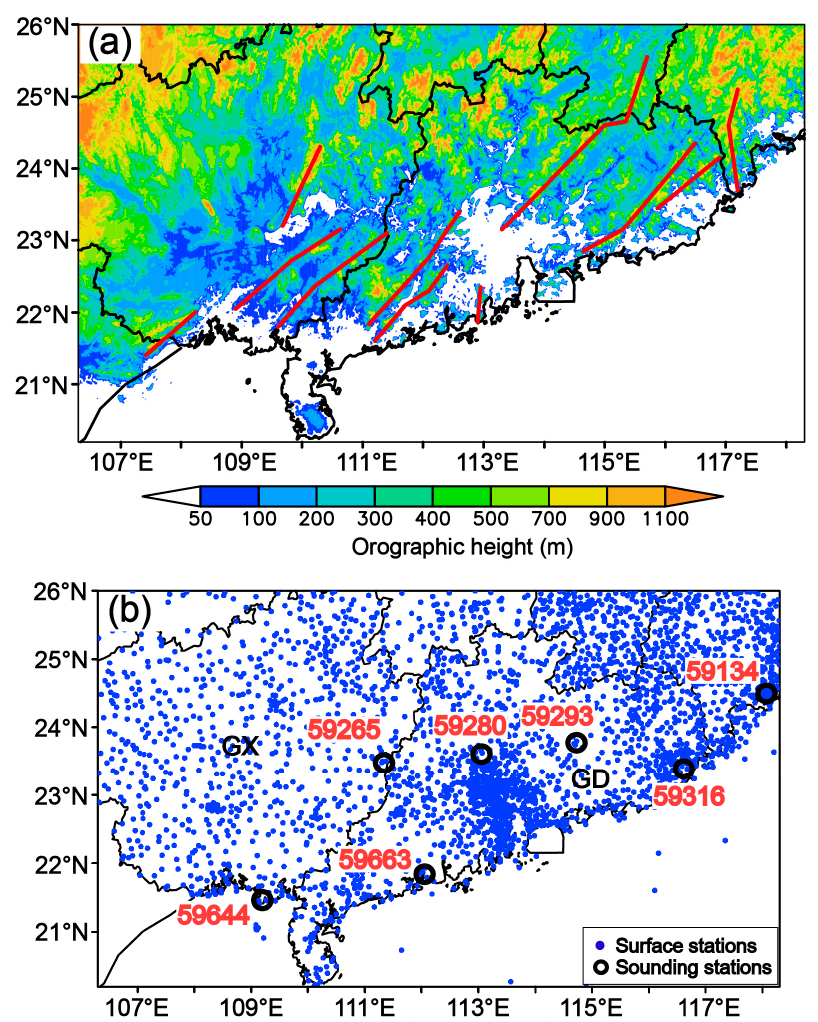
Figure 1. Distributions of ( a ) orography (color-shaded; units: m) and ( b ) observational stations over South China covering Guangdong (GD) and Guangxi (GX) provinces. The dots and circles in ( b ) indicate surface and radiosonde (marked with station IDs 59644, 59663, 59265, 59280, 59293, 59316, and 59134) stations, respectively. The red lines in ( a ) indicate the mountain lines illustrated in Figure 8.